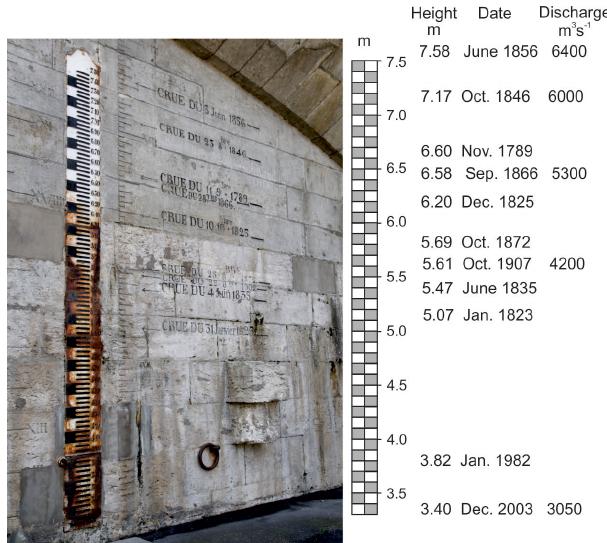
Figure 3. Historical flood marks of the River Loire on the Wil- son Bridge in Tours (France). The elevations of the flood marks after the Direction Regionale de l’Environment de l’Aménagement et du Logement (DREAL), Centre-Val de Loire (http://www.centre. developpement-durable.gouv.fr). Discharge values associated with the flood levels after Duband